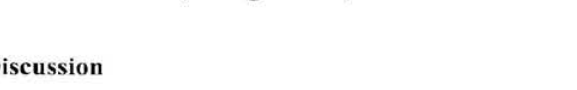
Figure 5. Serum concentration (mean ± S.E.M.) of total phospholipids in healthy individuals (open bars) and in CAD patients before percutaneous transluminal coronary angioplasty due to 1-artery disease (dotted bars), 2- or 3-artery disease (hatched bars), and restenosis (black bars). *The changes are significant if compared with healthy individuals (P <0.001 ) or with patients with 1-artery disease (P <0.001 ). with restenosis compared with patients with 1-artery disease (P <0.001). The correlation (r = - 0.321) between phospholipid and homocysteine concentra- tions was inverse (not